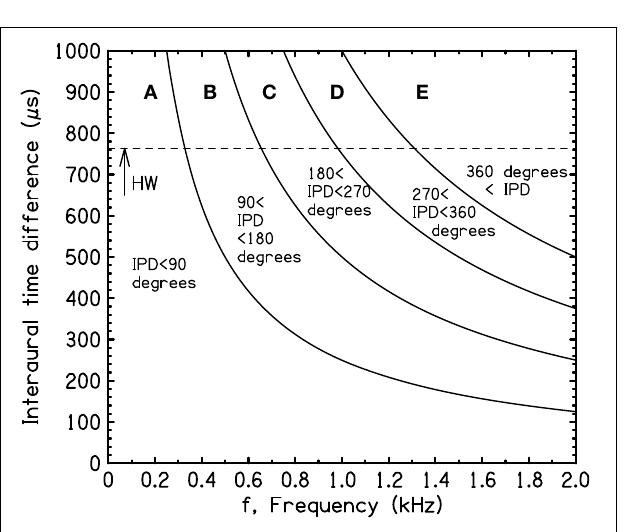
FIGURE 2 | Transformation of the iso-IPD boundaries in Figure 1 to a scale of frequency and interaural time difference (ITD). HW indicates the largest possible ITD for the average human head in free field.